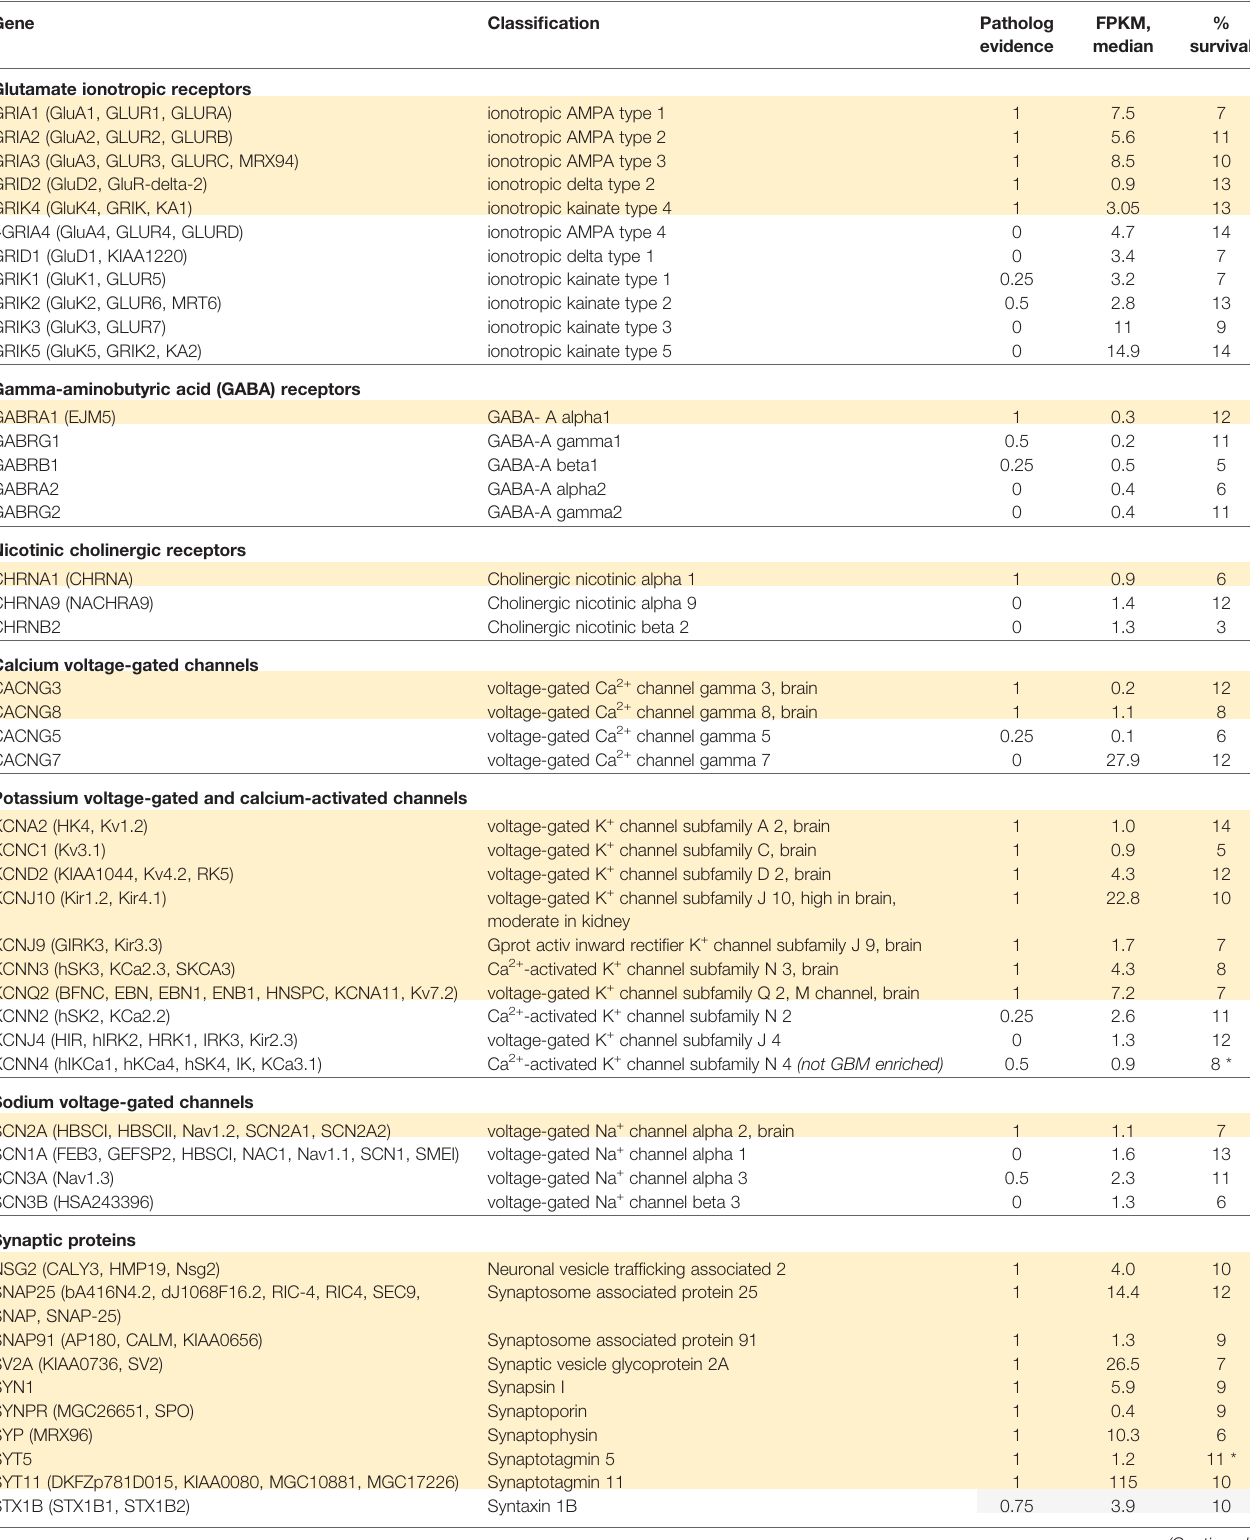
TABLE 1 | Summary of ion channels and synaptic proteins showing enriched transcript levels (FPKM, fragments per kilobase of transcript per million fragments mapped) in human glioblastoma biopsy samples, analyzed using TGCA RNAseq (n=153; Human Protein Atlas database); and percent survival at 3 years for patients with FPKM values greater than